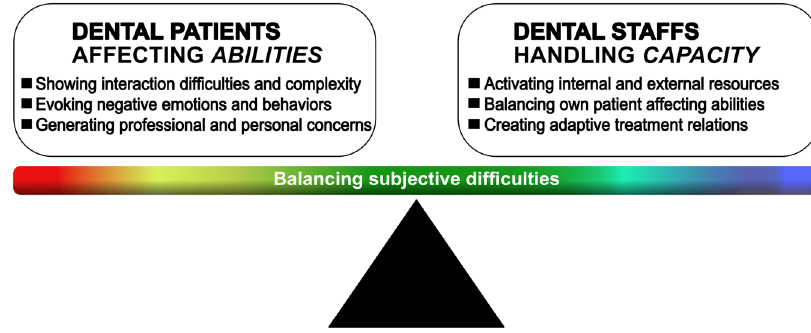
Fig. 2 Balancing subjective dif fi culties. The core category and suggestions for problem-solving